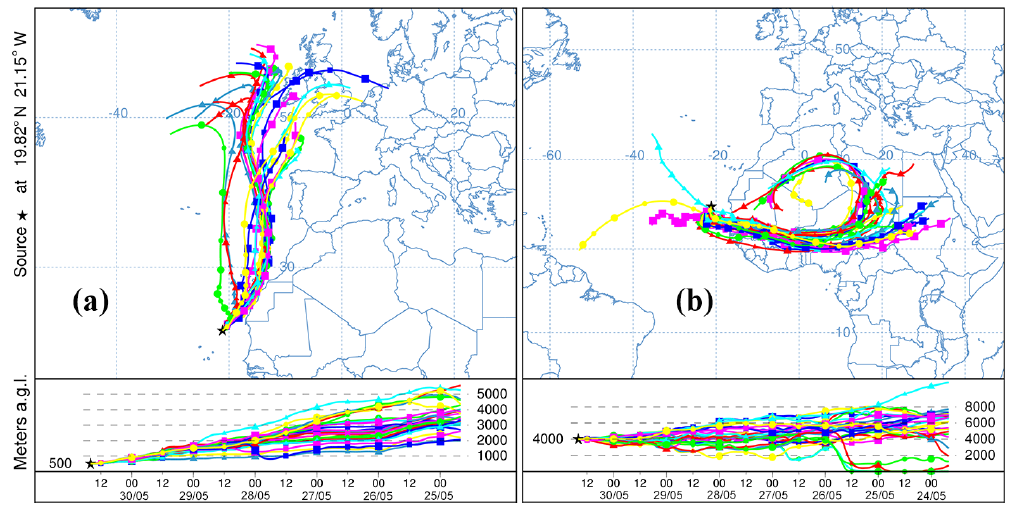
Figure 15. The 5d HYSPLIT backward trajectory ensemble arriving at 500m (a) and 6d HYSPLIT backward trajectory ensemble arriving at 4000m (b) height above RV Polarstern (black star) on 30 May 2018 at